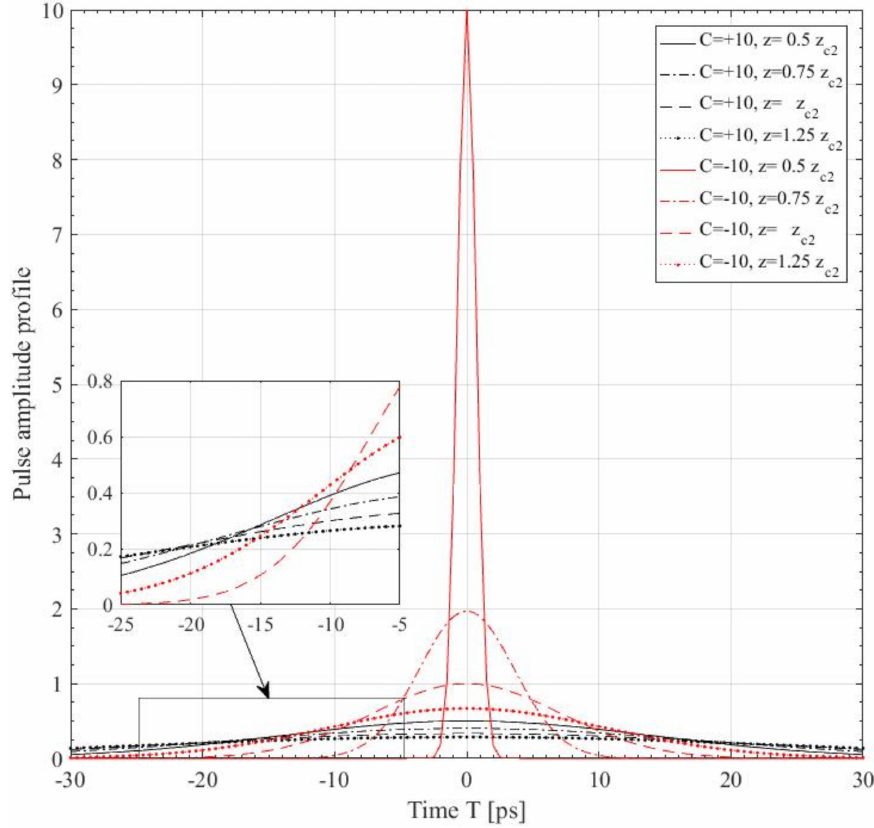
Figure 1. Pulse irradiance profiles, I , overtime, for several propagation distances and chirp parameters. Furthermore, the pulse amplitude and pulse width as a function of propagation distance, z, are depicted in Figure